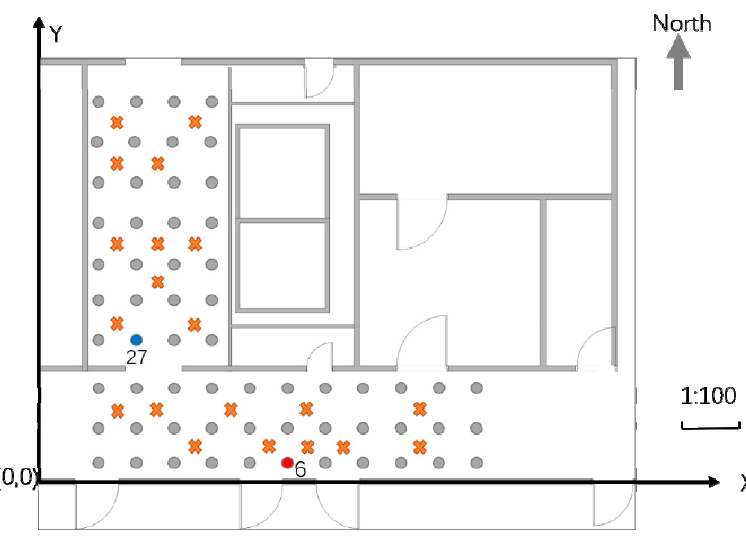
Figure 4. Plan view of the experimental area.